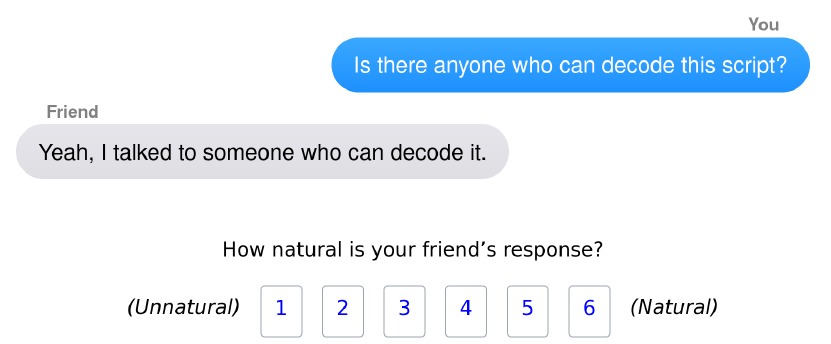
Figure 3. Screenshot of in-experiment dialogue from evidential existentiality norming study.